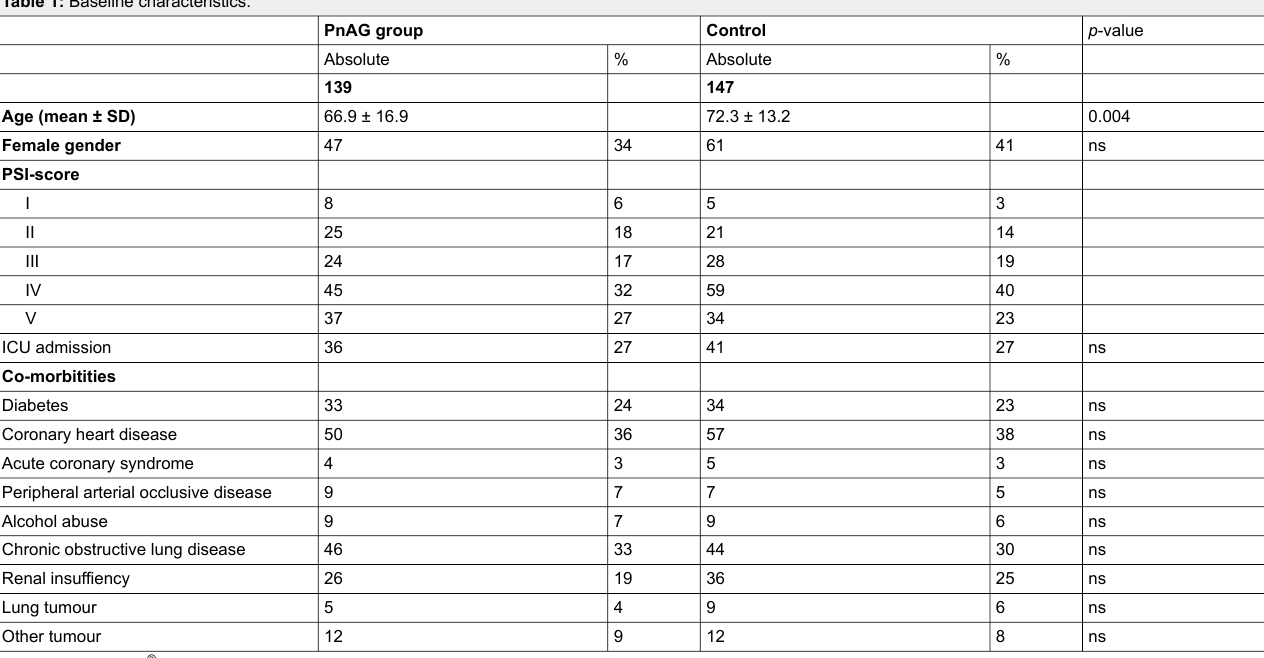
Table 1: Baseline